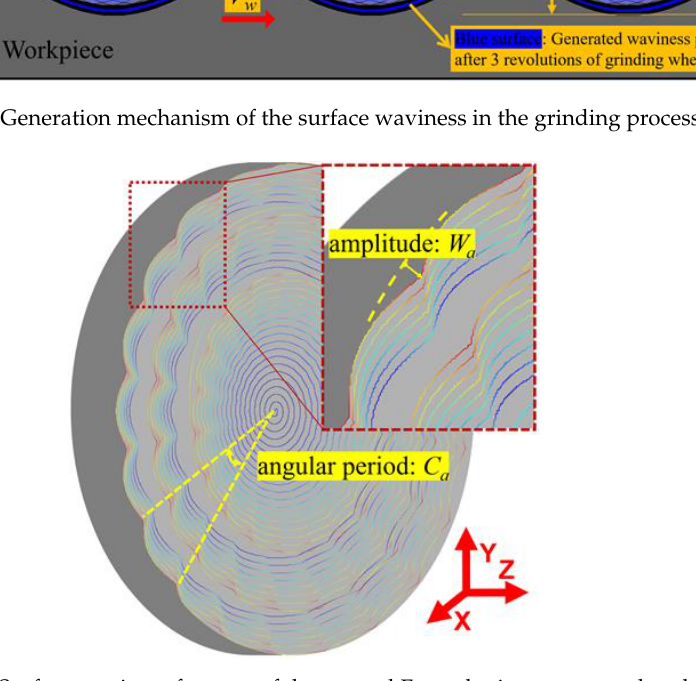
Figure 4. Surface waviness features of the ground Fresnel micro-structured mold.